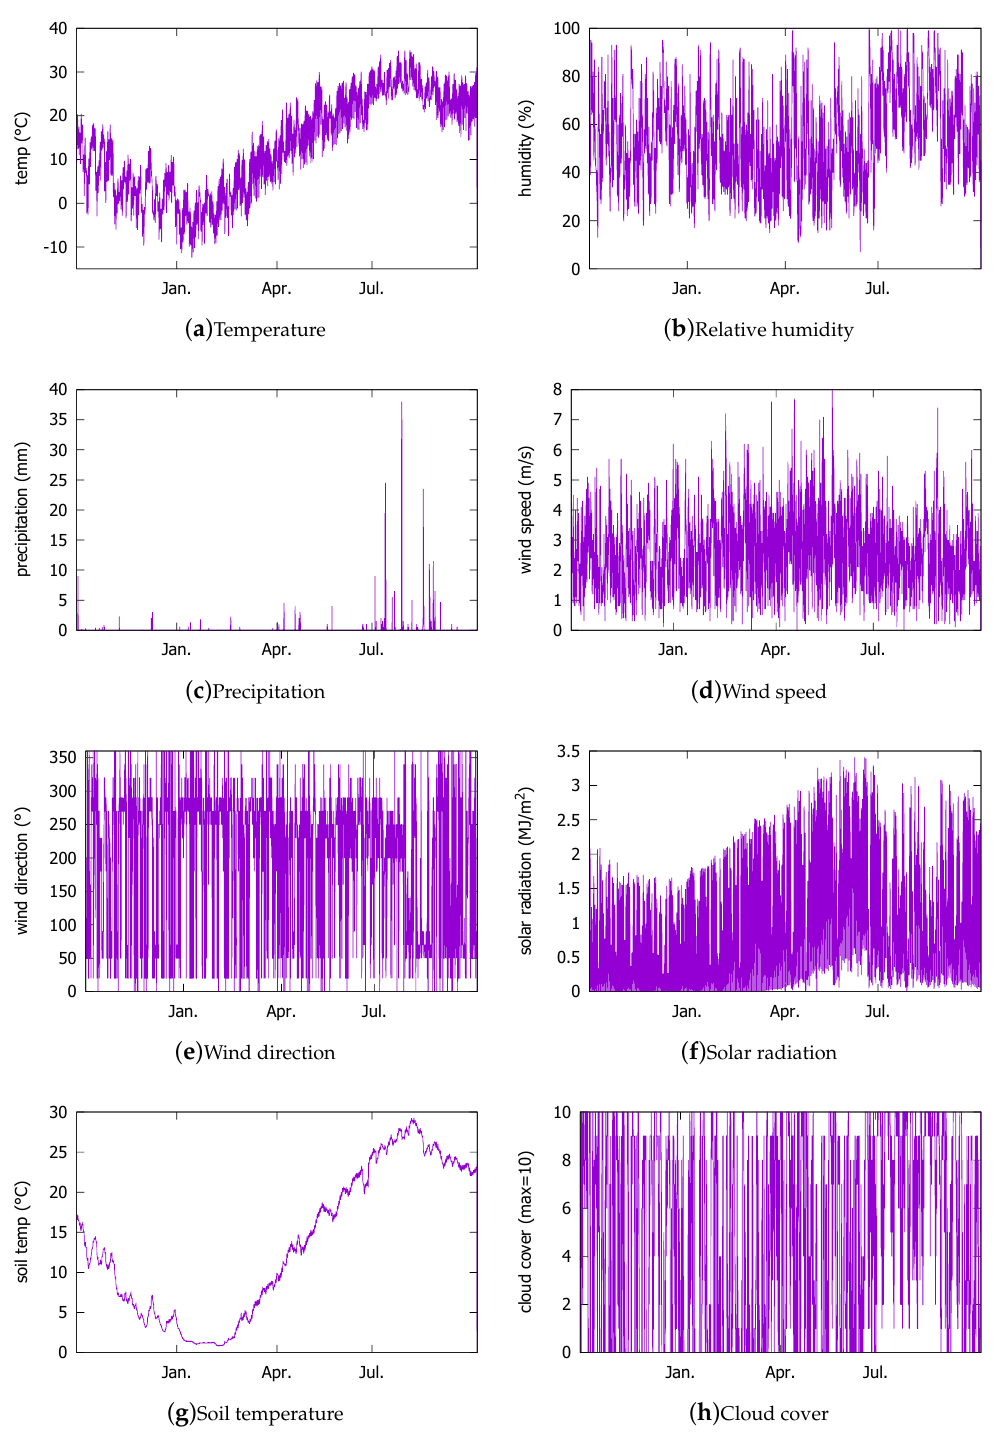
Figure 2. Hourly weather measurement data from the Korean Meteorological Administration (KMA) in year 2016 that are used in this